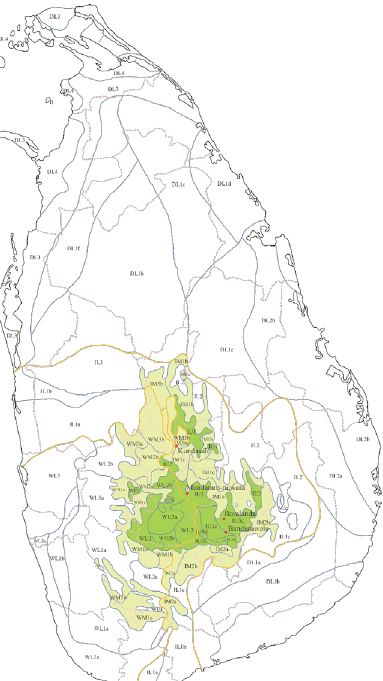
Figure 1: Sampling locations and agro-ecological regions (AER) identified for growing apple in Sri Lanka. Bright green AER represent the best regions and light yellowish green areas indicate the other potential regions to grow apple. The map was drawn